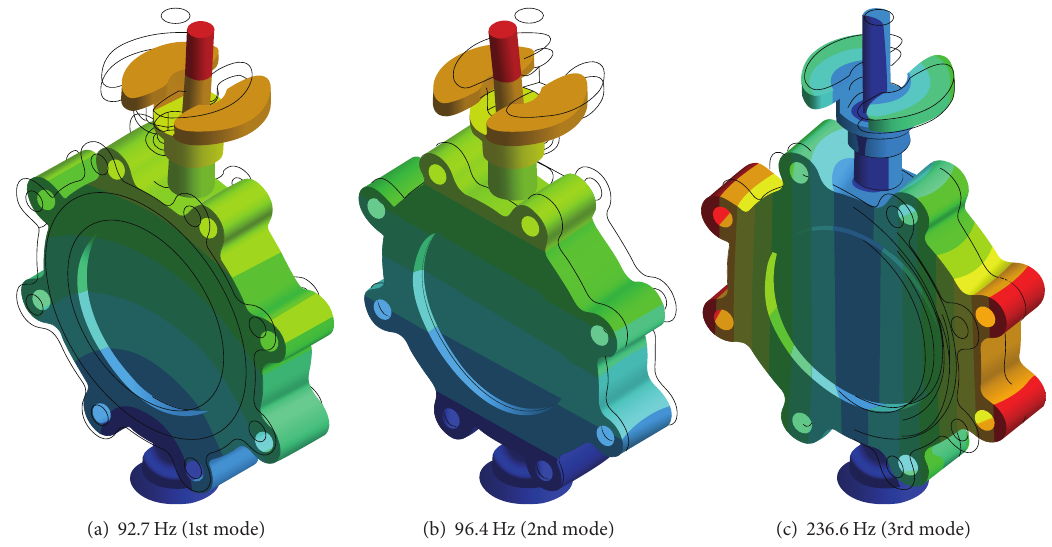
Figure 4: Frequencies at each mode obtained by modal